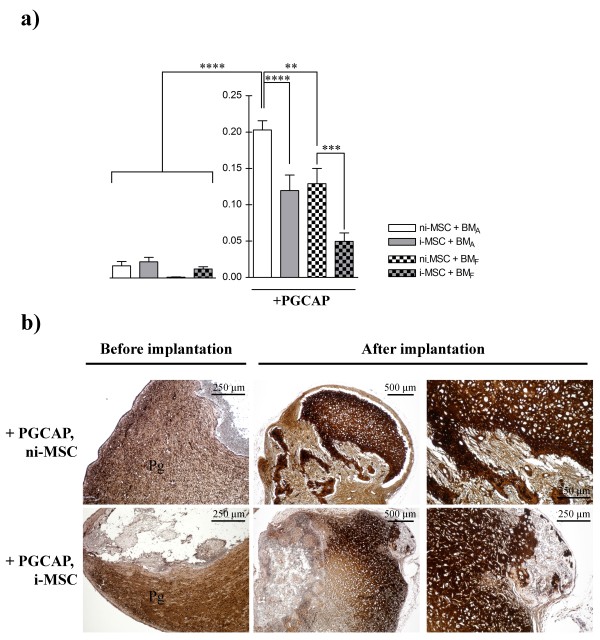
Bone formation areas are increased after ectopic implantation of MSC-loaded BMA embedded in PGCAP. (a) The average ratio of bone formation area in BMA 28 days after grafting was determined in each condition. The data are expressed as mean ± standard error of the mean. A statistically significant difference between individual conditions was revealed by analysis-of-variance test followed by Student Newman-Keuls test. *P <0.05, **P <0.01, ***P <0.00, ****P <0.0001. (b) Type I collagen immuno-staining (brownish color) was performed on BMA and BMF sections before implantation and 28 days after implantation. Original magnifications: ×4 and ×10. i-MSC, not osteogenic induced-mesenchymal stromal cell; MSC, mesenchymal stromal cell; ni-MSC, not induced-mesenchymal stromal cell; PGCAP, platelet glue obtained from cryoprecipitation of apheresis platelet products.